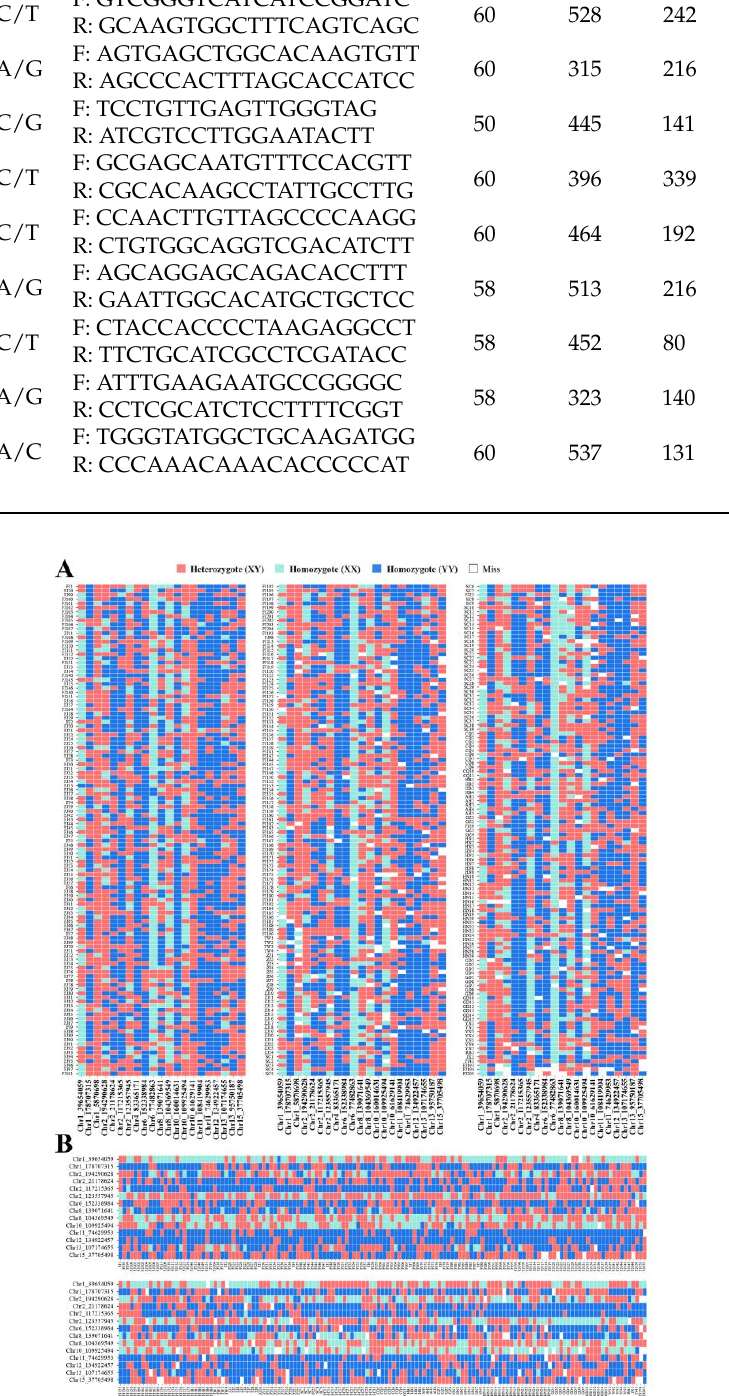
Figure 5. SNP Fingerprints of 349 tea trees. Each line represents one SNP locus, and each column represents one sample. Red, Green and Blue color represents the Homozygote (XY), Homozygote (XX) and Heterozygote (YY), respectively. Blank represent the Missing data. ( A ) Twenty-one SNPs perfectly differentiated 349 tea trees; ( B ) fourteen SNPs perfectly differentiated 279 non-EDV.